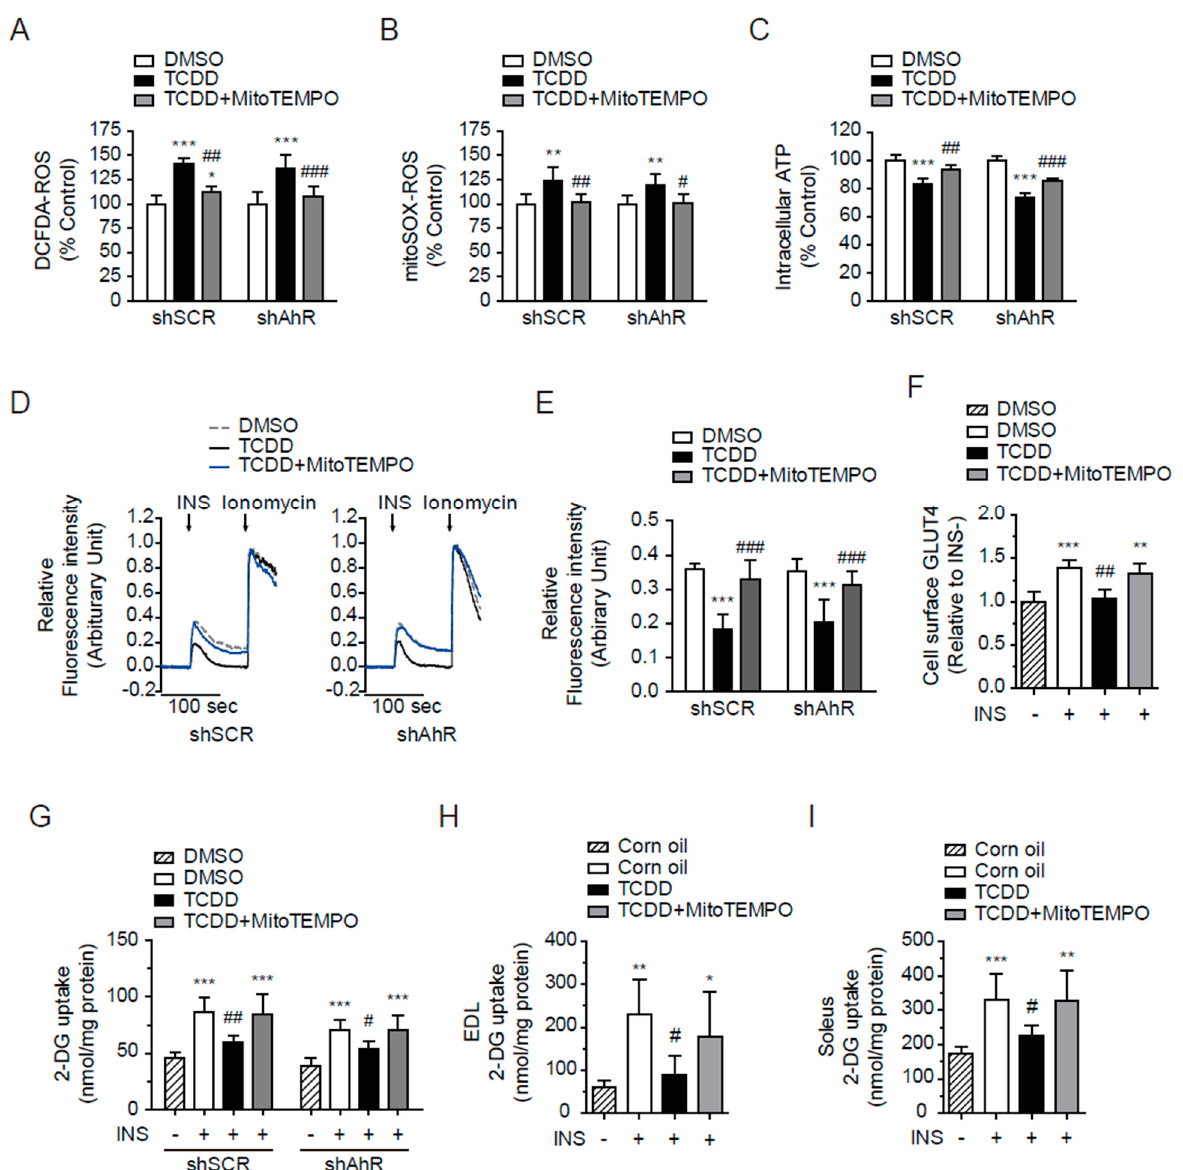
Figure 8. MitoTEMPO prevented TCDD-induced insulin resistance in muscles. The shSCR and shAhR C2C12 cells were incubated with 100 pM of TCDD with or without 10 µ M of MitoTEMPO for 24 h in an experiment with ROS measurements and for 48 h in other experiments. ( A , B ) ROS generation. After the TCDD treatment, cytosolic or mitochondrial ROS were observed with a fluorometer using DCFDA (1 µ M, ( A )) or mitoSOX (5 µ M, ( B )), respectively. ( C ) The intracellular ATP contents in the cells were determined using CellTiter-Glo ® . ( D ) The cells were loaded with 3 µ M of Fluo-4 AM